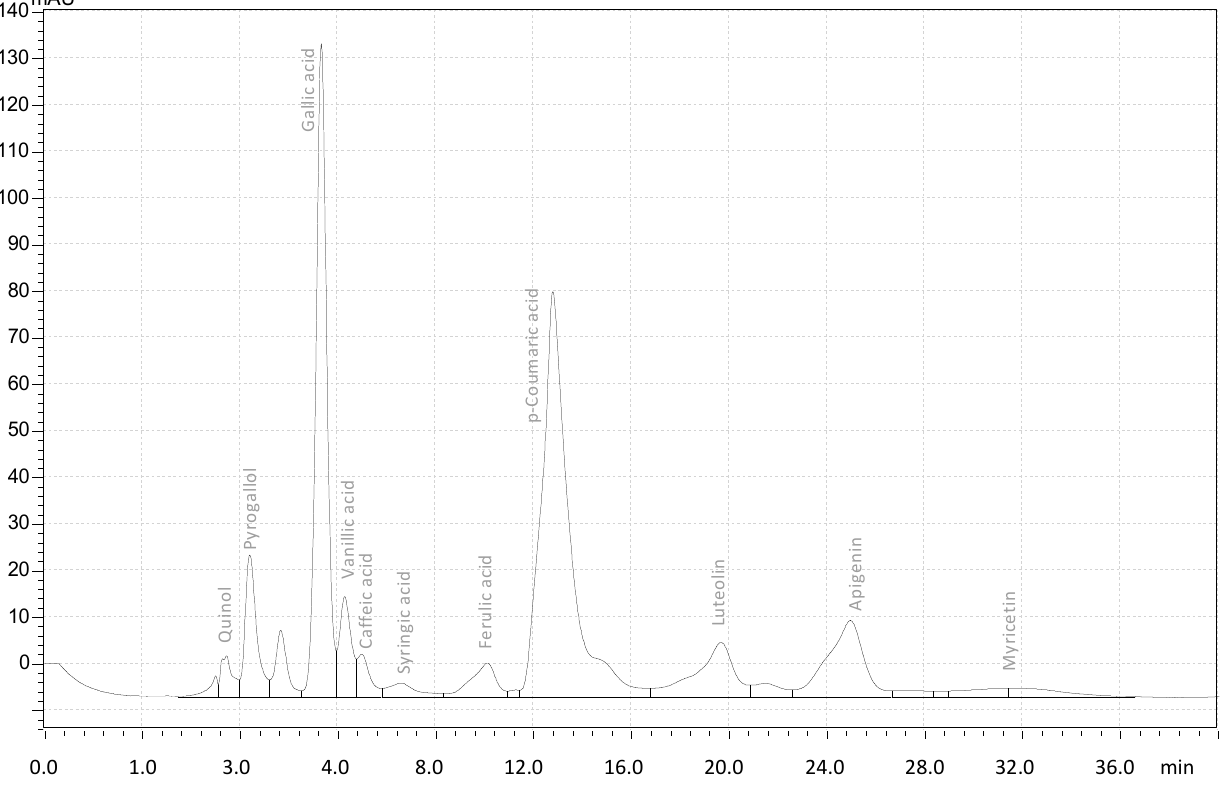
Figure 1. HPLC chromatogram of phenolic and flavonoid compounds in Ajwa date pits’ methanolic extract.